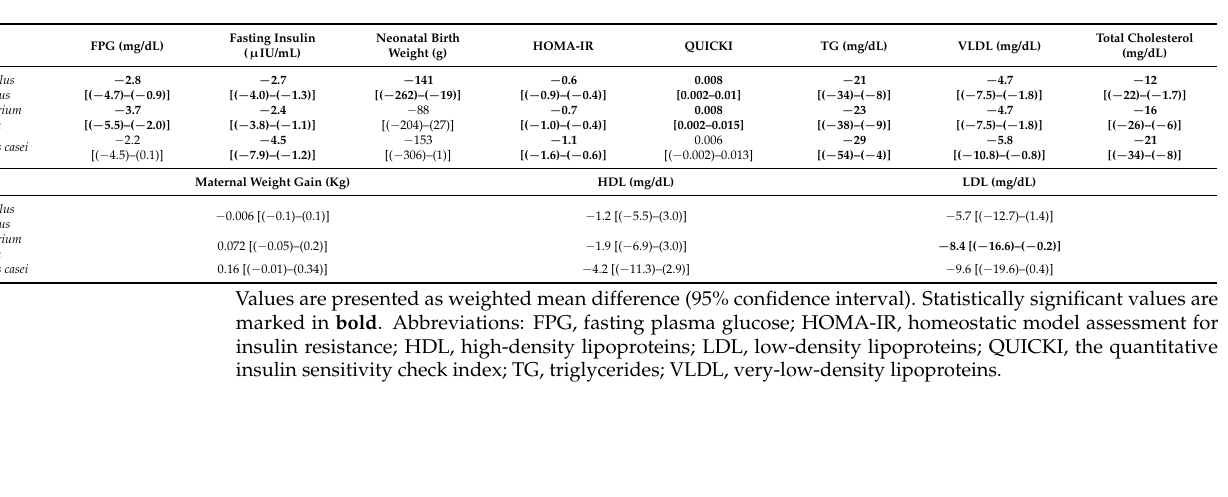
Table 3. Sub-analysis of metabolic effects according to specific